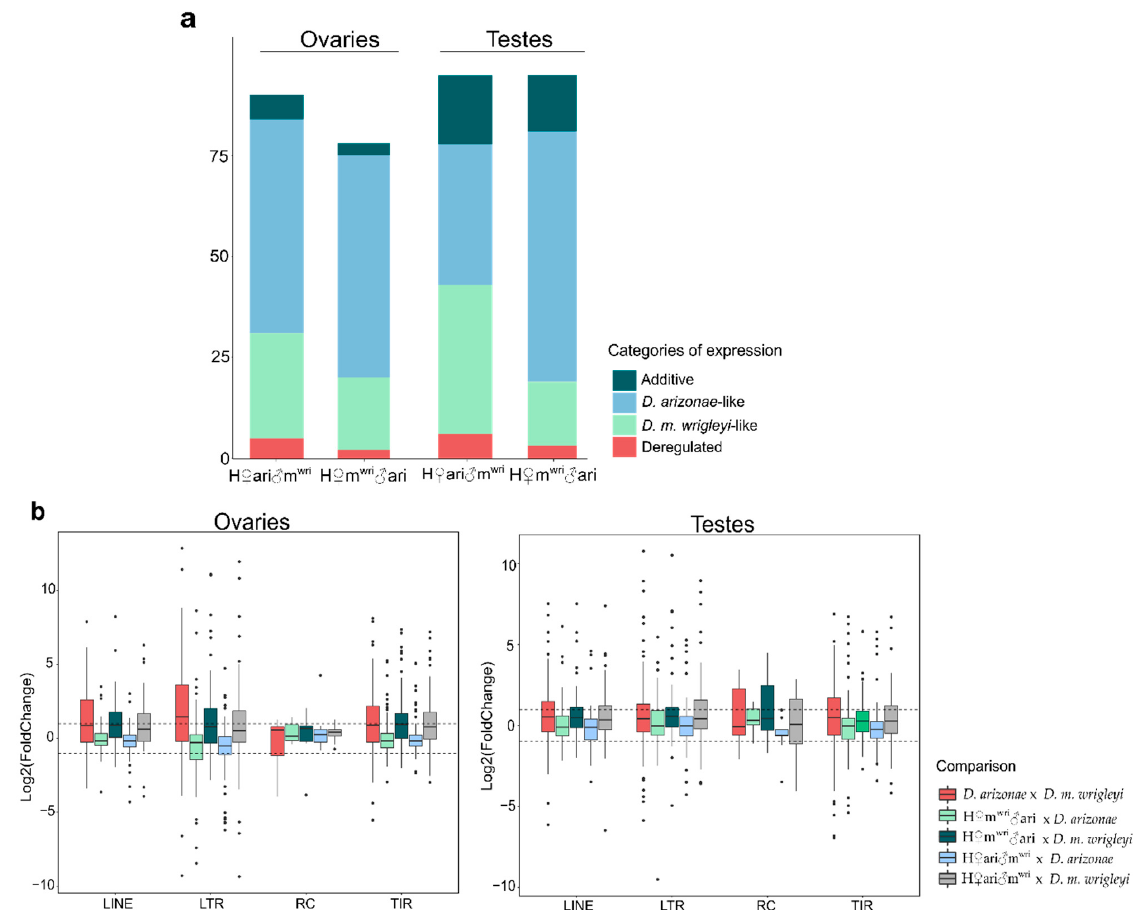
Figure 2. TE expression in hybrids gonads. ( a ) The total number of TE families in hybrid ovaries and testes classified in different categories of expression. ( b ) Global expression of TEs orders according to Log2(FoldChange), between parental lines and between hybrids and parental lines. Dotted lines represent Log2(FoldChange) > |1| and p -value adjusted < 0.05. In the female gonads of H ♀ m wri ♂ ari, the five TE families deregulated were classified as RC ( Helitron-5 ), TIR ( REP-2, BARI-1 ), and LTR ( Gypsy-6 and Copia-29 ). Interestingly, only the retrotransposon Copia-29 was also DE between the parental lines, and all TE families, except Helitron-5 , were common to D. arizonae and D. m. wrigleyi genomes. In H ♀ ari ♂ m wri ovaries, the two deregulated TEs were BARI-1 /TIR (such as H ♀ m wri ♂ ari) and Copia-3 /LTR (DE in between parental lines), both present in the parental genomes. The deregulated TEs found in H ♀ m wri ♂ ari testes were classified as LTR ( Copia-29, Gypsy-14, Gypsy-30, Gypsy-35 ) and RC ( Helitron-2 ) elements. Moreover, two of these TEs ( Gypsy-35 and Helitron-2 ) were also deregulated between parental lines, and only the Helitron-2 family was exclusive to D. m. wrigleyi parental genome. In testes of H ♀ ari ♂ m wri , the three TE families were classified as TIR ( piggyBac-3 ) and LINE ( Helena